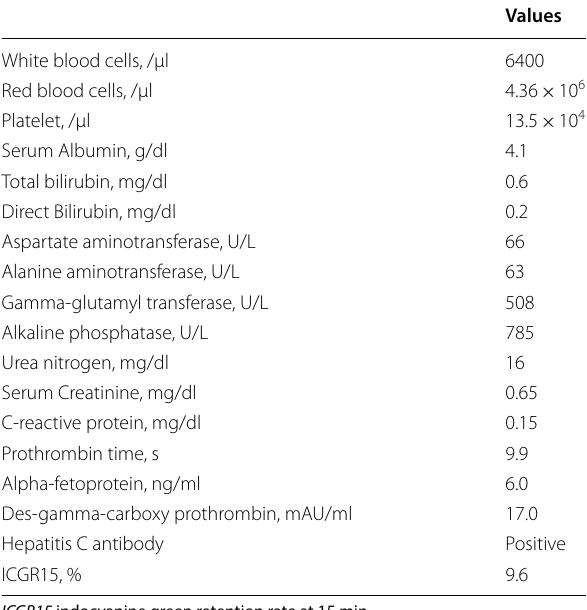
Table 1 Preoperative laboratory